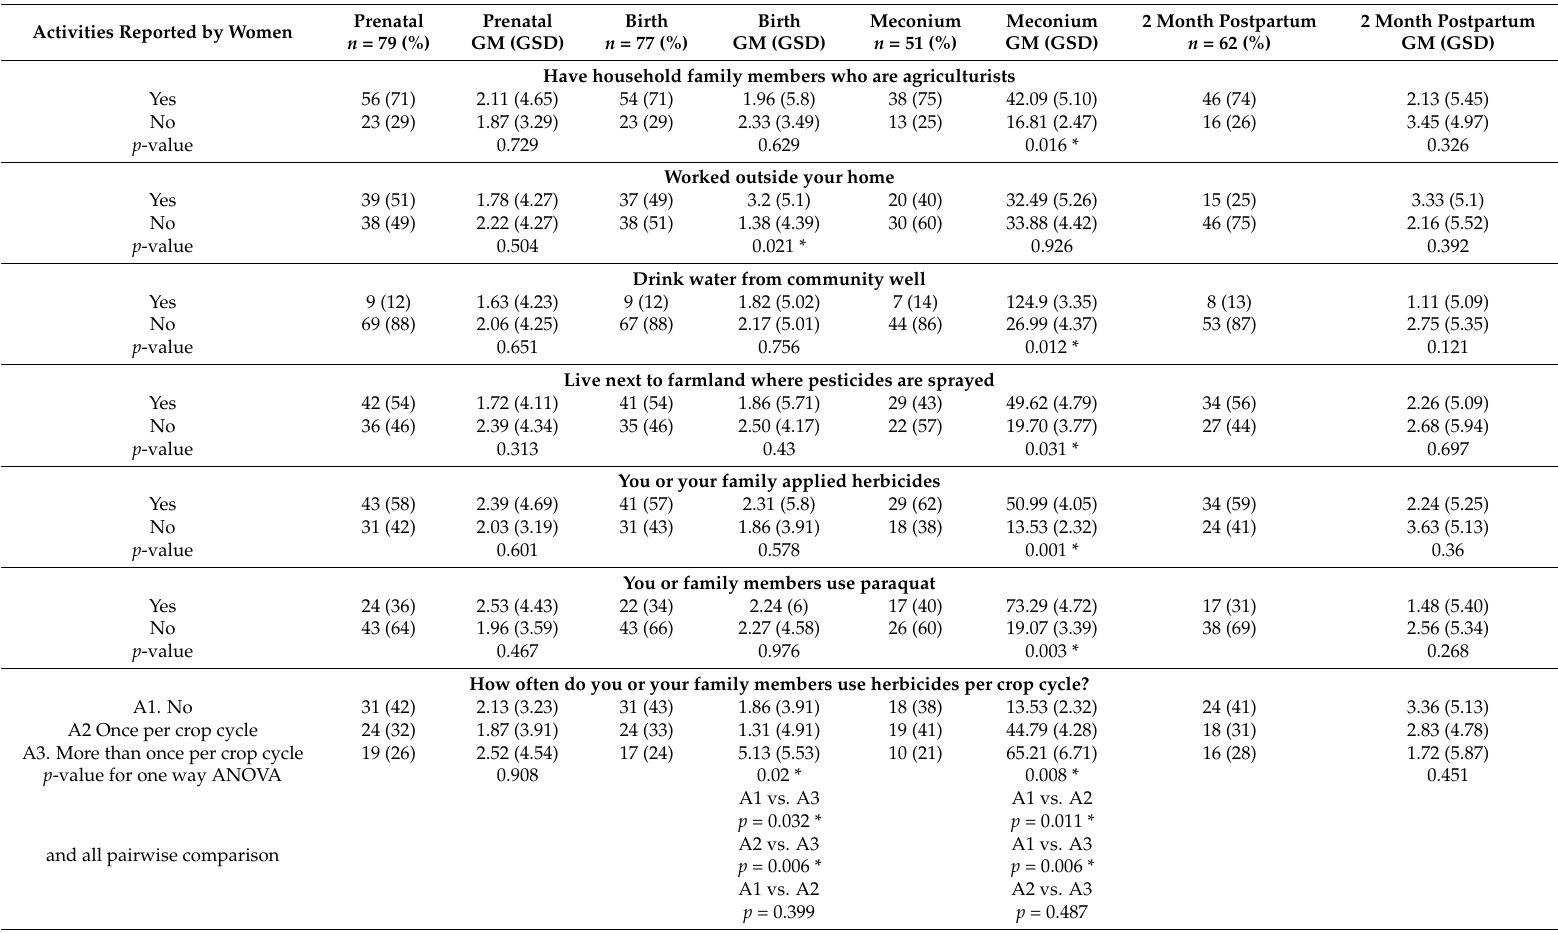
Table 4. Urinary paraquat concentration of women at 28th week of pregnancy, and delivery and paraquat concentration in meconium samples categorized by exposure